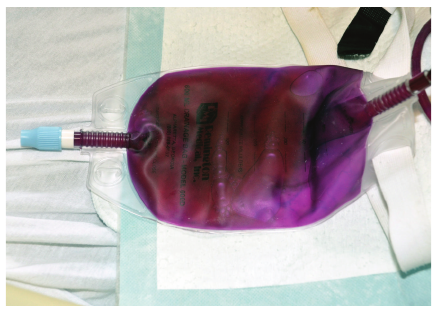
Figure 1: Dark purple discoloration of urinary bag.